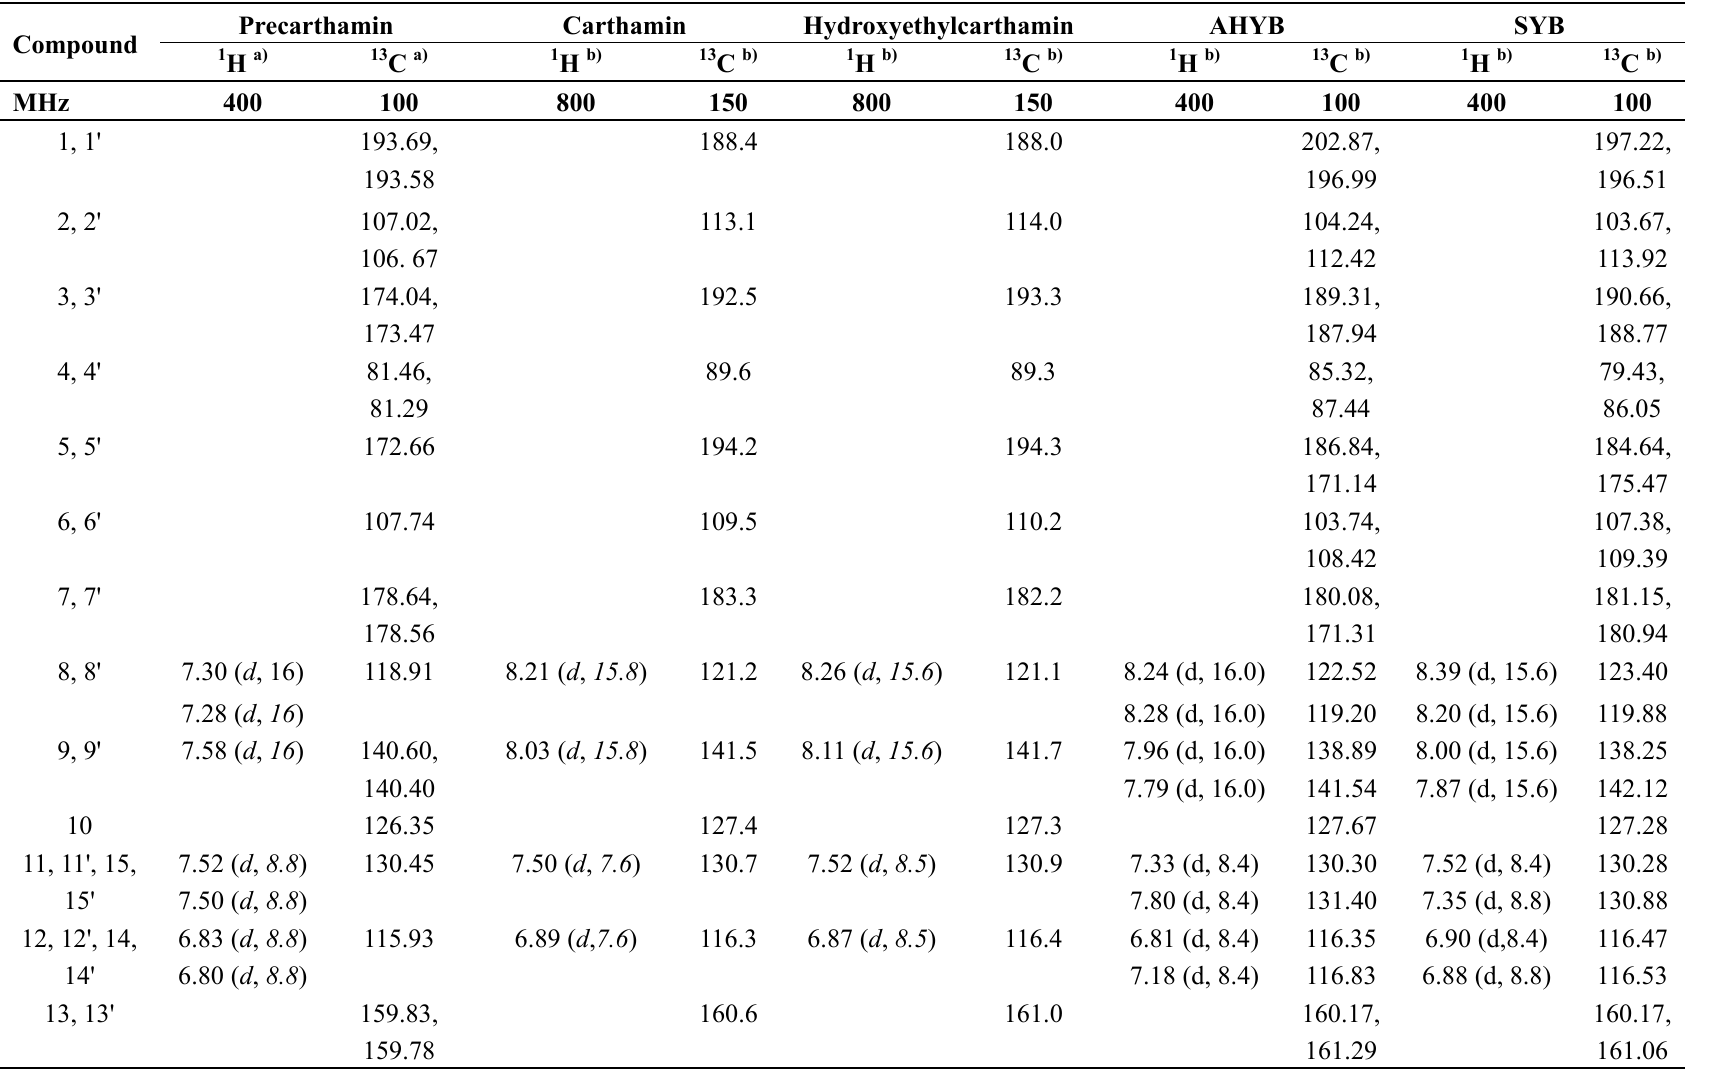
Table 13. NMR data for precarthamin, carthamin, hydroxyethylcarthamin, AHSYB, and